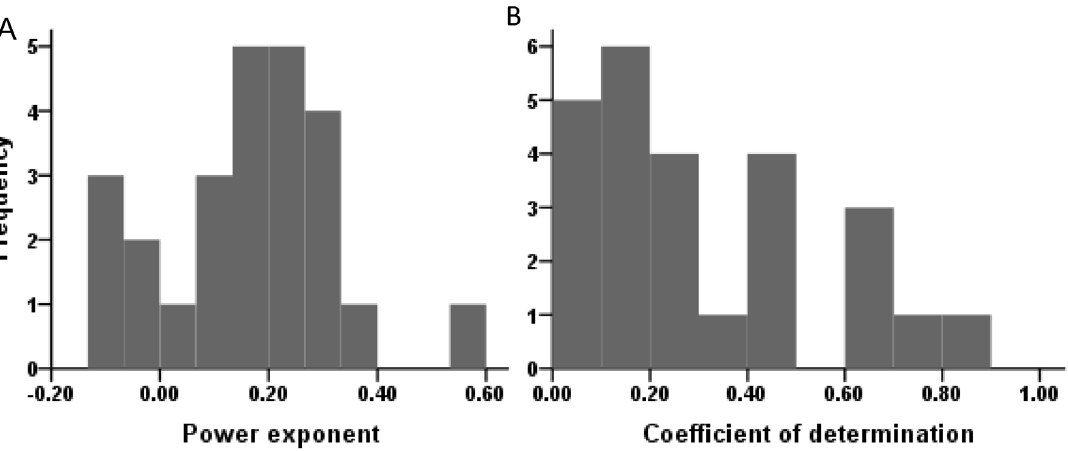
Figure 5. Regression parameters of power function. Power exponents (A) and coefficients of determination (B) for the relationship between sediment concentration and rainfall intensity for all tests.